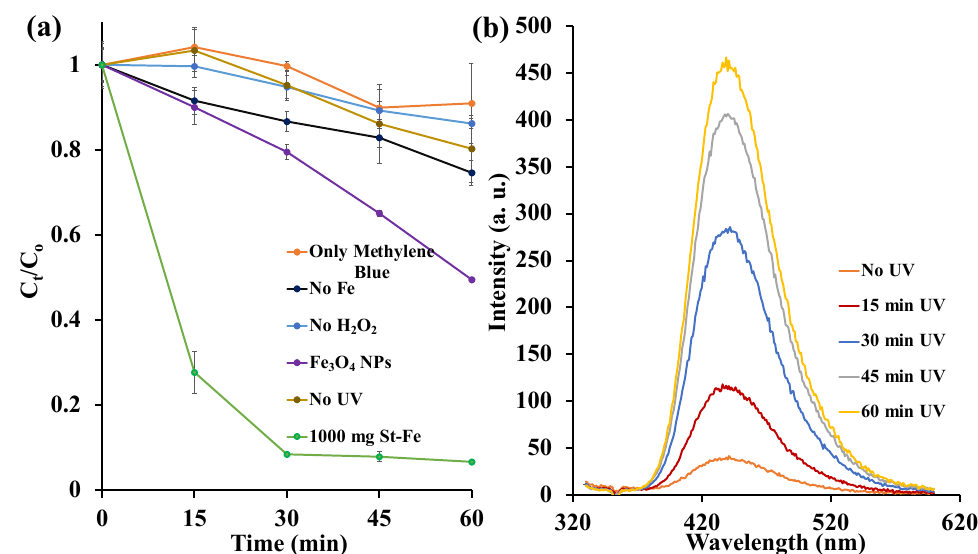
Figure 3. ( a ) MB degradation control experiments (10 mL volume, 4 mg/L) at pH 3 with 290 μ mol/L Fe (1000 mg St–Fe NPs), 360 μ mol/L H 2 O 2 , and UV light unless otherwise mentioned; ( b ) hydroxyl radicals detected using 44 μ mol/L Fe (1000 mg St–Fe NPs), 55 μ mol/L H 2 O 2 , and 0.06 mol/L terephthalic acid at pH 4 after UV irradiation for the specified time intervals.